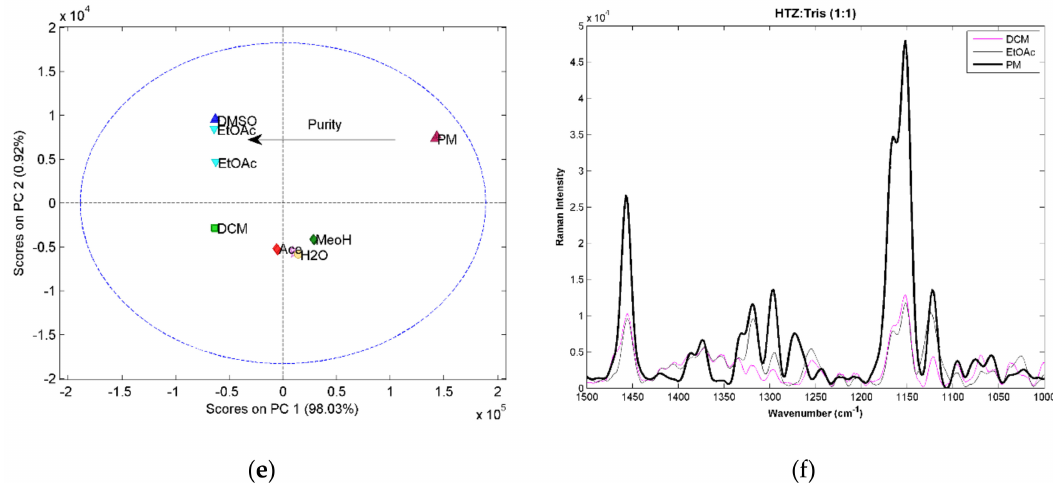
Figure 1. ( a ) Principal component analysis (PCA) score plot constructed with the mid infrared spectroscopy (MIRS) spectra from the system HTZ:Tris (1:1); ( b ) MIRS spectra of the samples produced with DCM and EtOAc and from the physical mixture (PM); ( c ) PCA score plot constructed with the near infrared spectroscopy (NIRS) spectra from the system HTZ:Tris (1:1); ( d ) NIRS spectra of the samples produced with DCM and EtOAc and from the PM; ( e ) PCA score plot constructed with the Raman spectroscopy (RS) spectra from the system HTZ:Tris (1:1); ( f ) RS spectra of the samples produced with DCM and EtOAc and from the PM. Colors refer to different solvents (dark green: MeOH; pink: EtOH; red: Ace; green: DCM; dark blue: DMSO; blue: EtOAc; yellow: H 2 O; dark red: